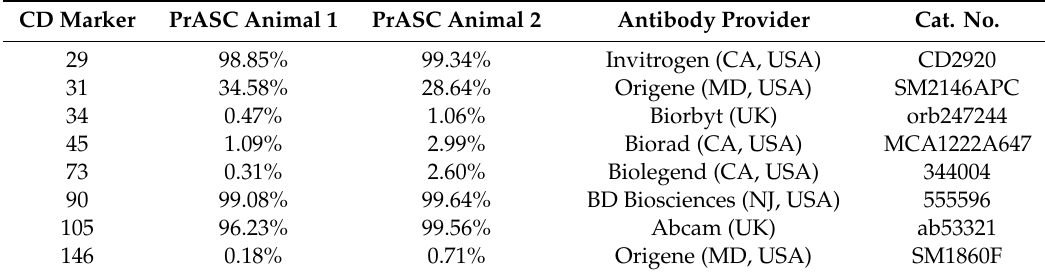
Table 1. Flow cytometry analysis of isolated adipose-derived stromal